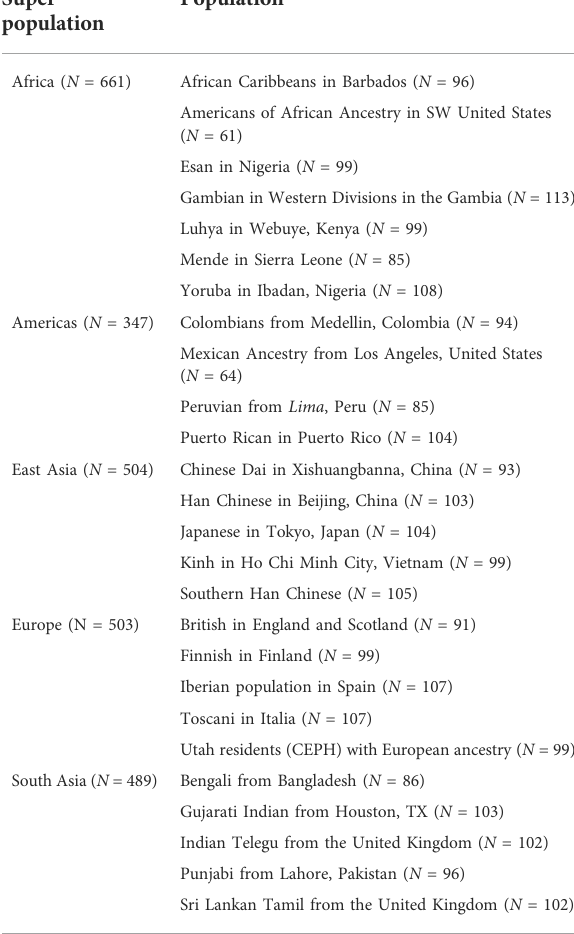
TABLE 1 Sampled populations and super